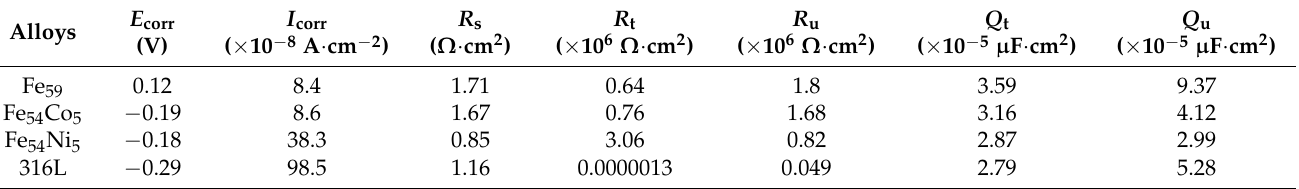
Table 2. Electrochemical parameters derived from potentiodynamic polarization curves and EIS